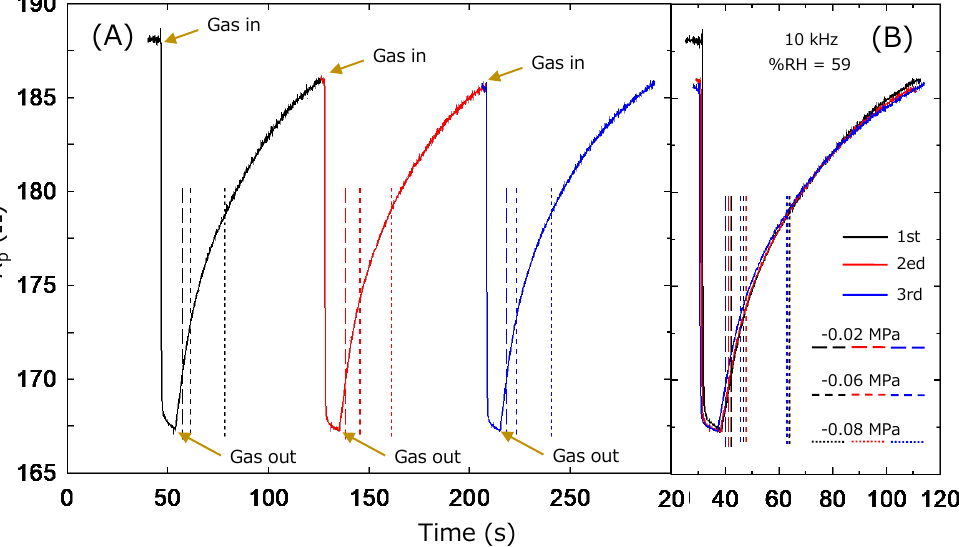
Figure 9. Repeatability of the R p of ZnAl 2 O 4 /Al device against changing pressure between the vacuumed state as %RH = 0 and normal atmosphere as %RH = 59. ( A ) R p is plotted against absolute time. ( B ) R p is plotted against the relative time of each cycle